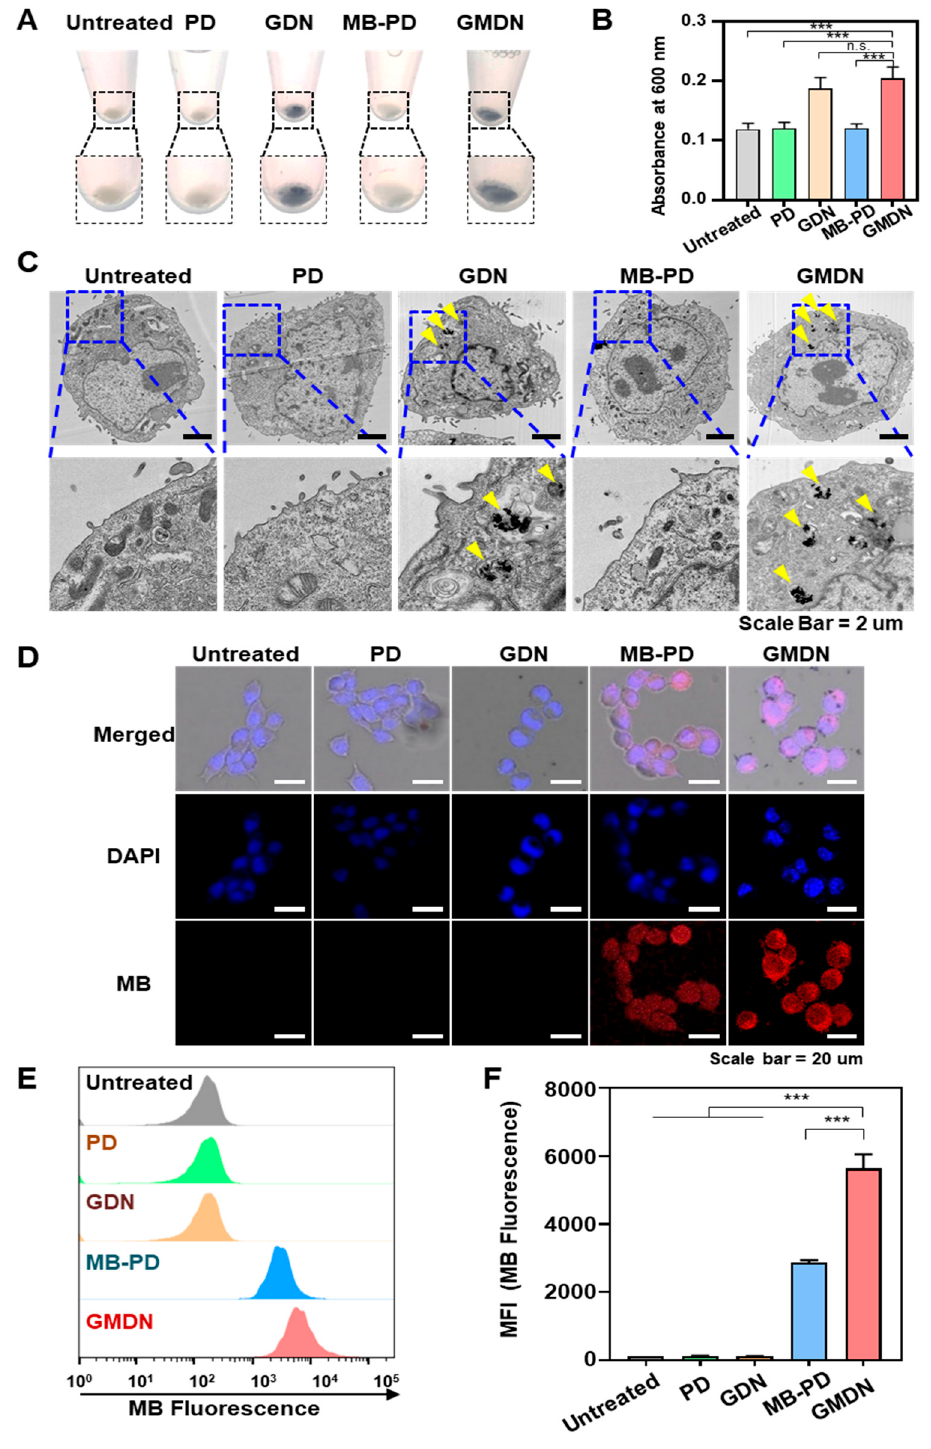
Figure 3. Cellular uptake of nanoclusters. ( A ) Cell pellets were observed after cells were treated with PD, GDN, MB-PD, or GMDN. ( B ) Absorbances of cell suspensions were measured at 600 nm. ( C ) Cellular internalization of gold nanoclusters was observed by TEM imaging. ( D ) Cells were treated with the various formulations and fluorescence was observed by confocal microscopy. ( E , F ) Cellular uptake of nanoclusters was measured by flow cytometry ( E ) and analysis of average fluorescence intensity ( F ) (*** p < 0.001).